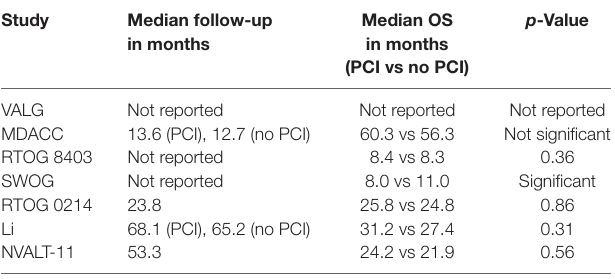
TABLe 4 | RCTs evaluating PCI-related OS in